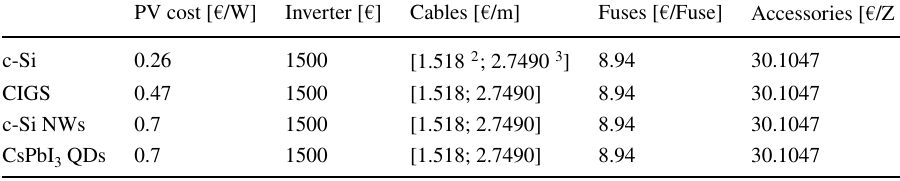
Table 2 Input parameters for initial investment computation